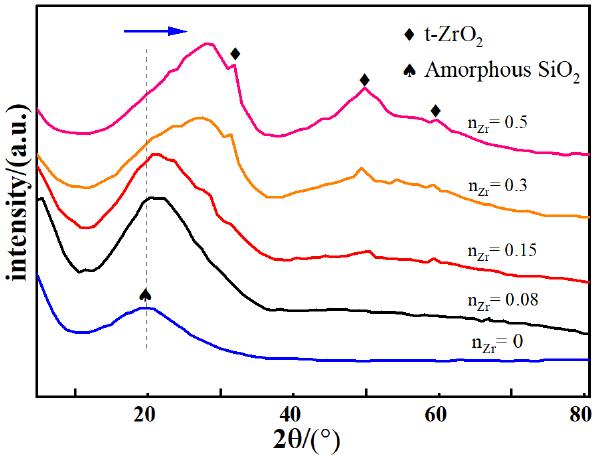
Figure 4. XRD patterns of ZrO 2 -MSiO 2 materials with various n Zr .